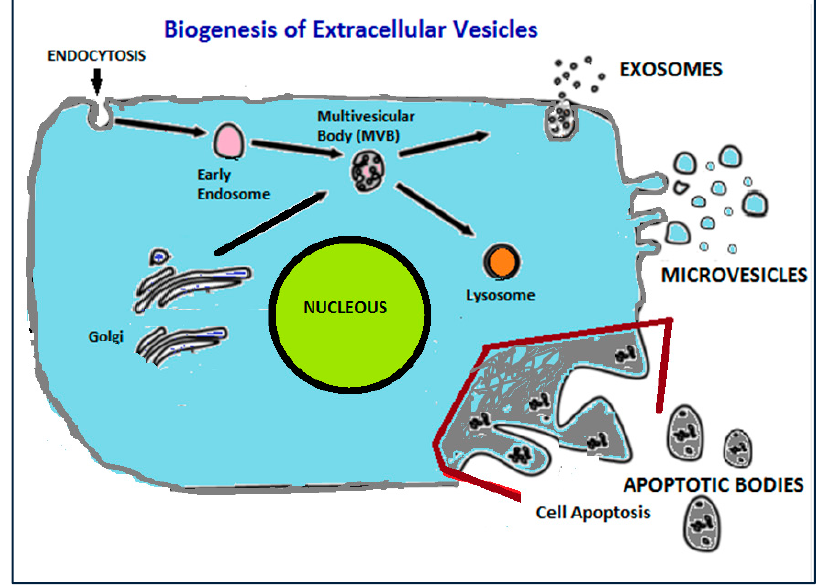
Figure 1. Representation of the biogenesis of Extracellular vesicles from eukaryotic cell.